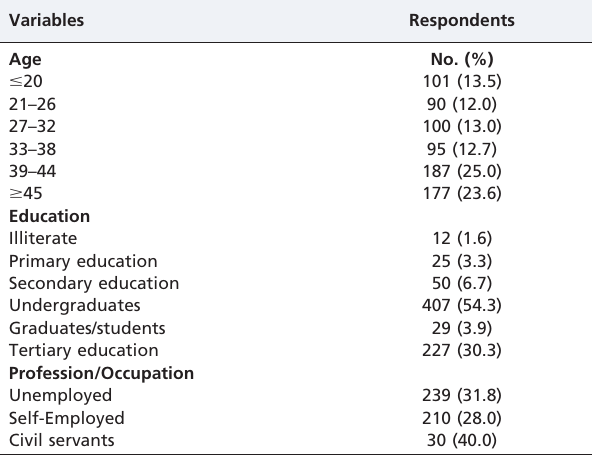
Table I - Sociodemographic Distribution And Screening Guidelines N=